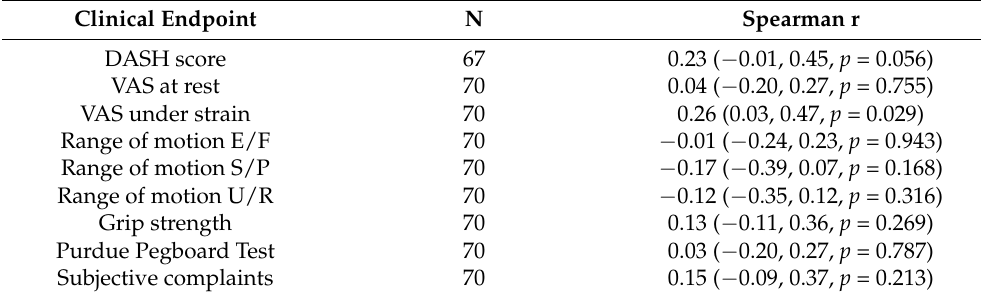
Table 4. Correlation and confidence intervals between WMSDs and other clinical endpoints.